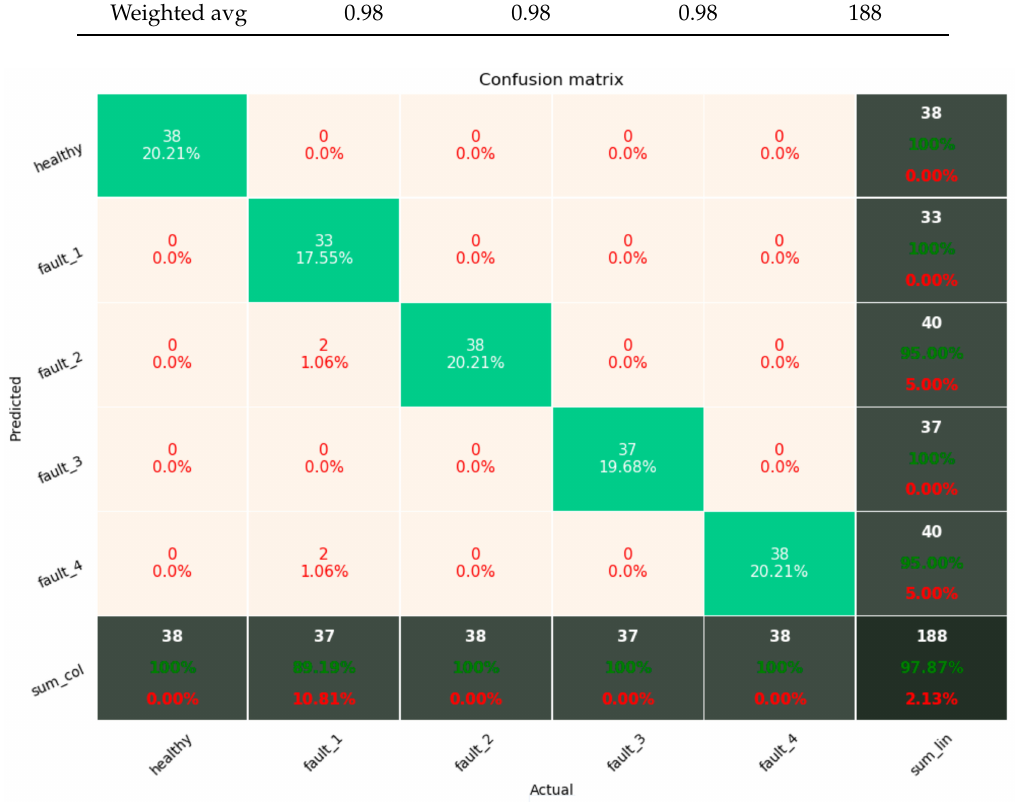
Figure 8. Confusion matrix for the testing dataset (Fault 0: healthy, Fault 1: bearing axis deviation, Fault 2: stator and rotor friction, Fault 3: rotor end ring break, and Fault 4: poor